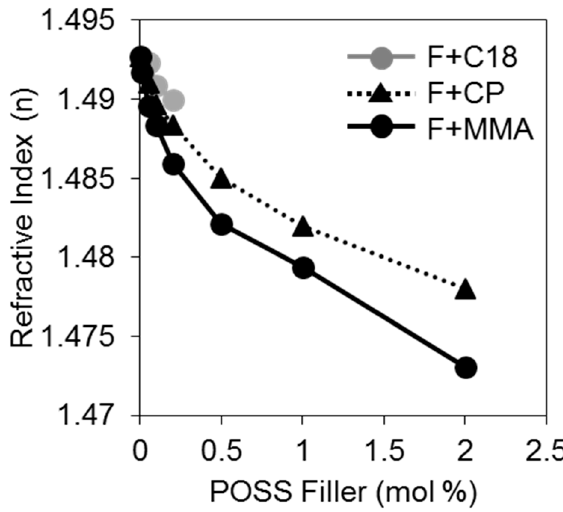
Figure 2. Refractive indices (n) of the PMMA hybrids containing various concentrations of the POSS fillers.